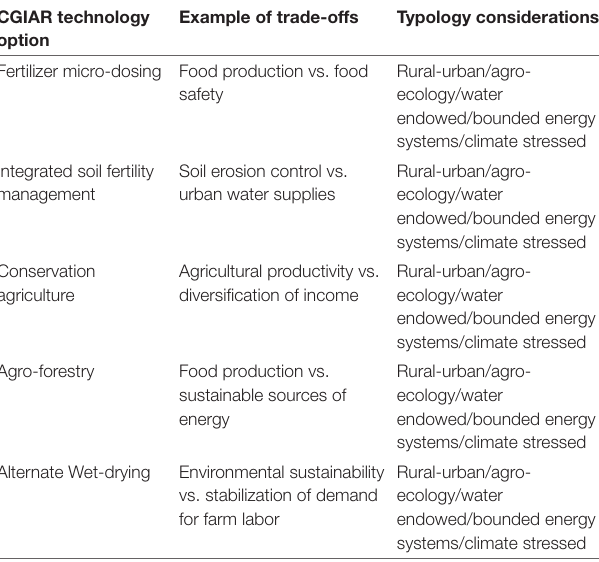
TABLE 1 | The use of typologies in impact evaluation